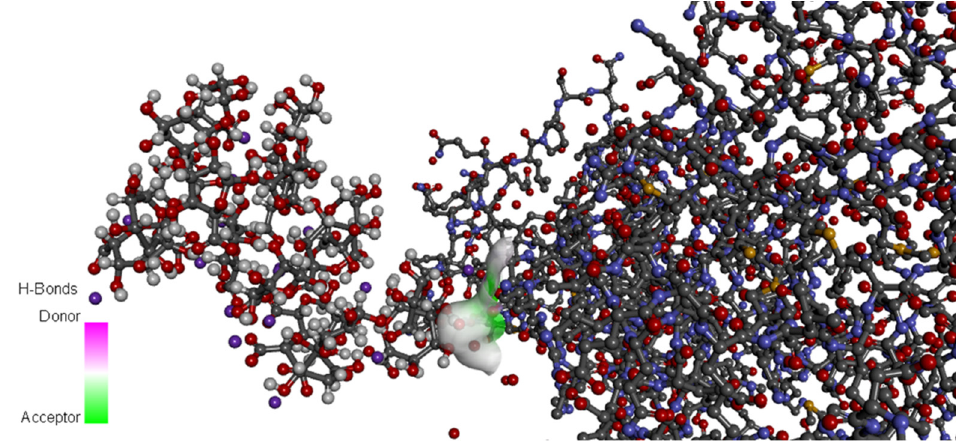
Figure 3. Example of in silico visualization of the biofunctionalized polymer [31].